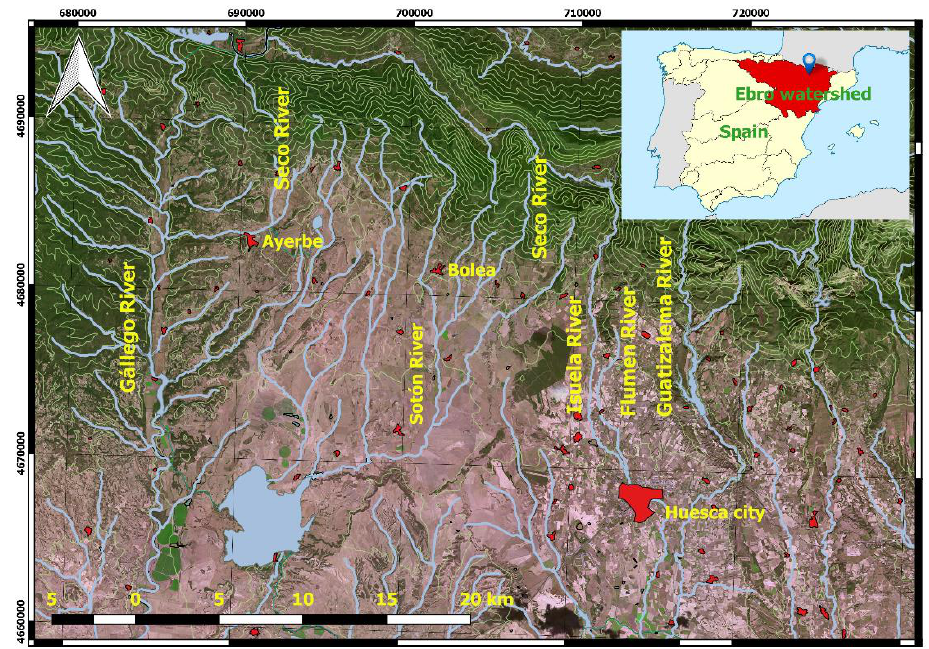
Figure 1. Location of the area of study, in the west part of Hoya de Huesca County. Urban areas are shown in red. The inset in the upper right corner shows the location of Ebro watershed in Spain.